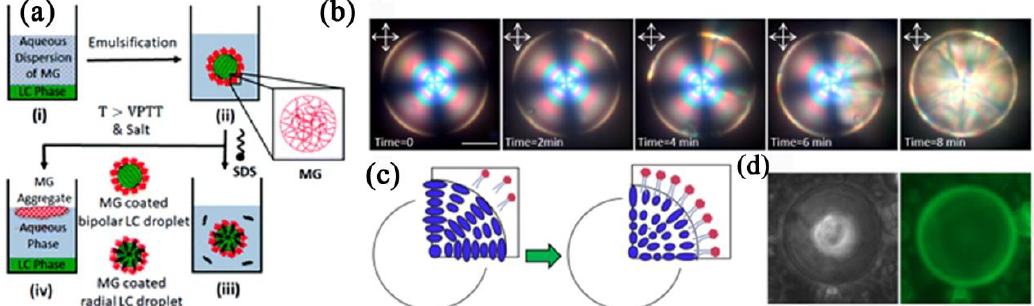
Figure 13. ( a ) Schematic illustration of essential steps for emulsification of (i) two-phase system, (ii) formation of an aqueous dispersion of MG stabilized LC droplets, (iii) response of LC droplets to SDS, and (iv) on-demand emulsion breaking. Reconfiguration of high-chirality LC droplets in the presence of DLPC amphiphiles. Reprinted with permission from ref. [201]. Copyright 2019 Royal Society of Chemistry. ( b ) Reflection mode POM images of reconfiguration dynamics in 30 µm high-chirality droplets in the presence of 0.5 mM DLPC. ( c ) Schematic of the planar to homeotropic ordering transition. ( d ) Bright-field and fluorescent image of adsorbed labeled DLPC amphiphiles on the chiral droplet’s interface. Reprinted with permission from ref. [202]. Copyright 2022 MDPI. The scale bar is 20 µm.